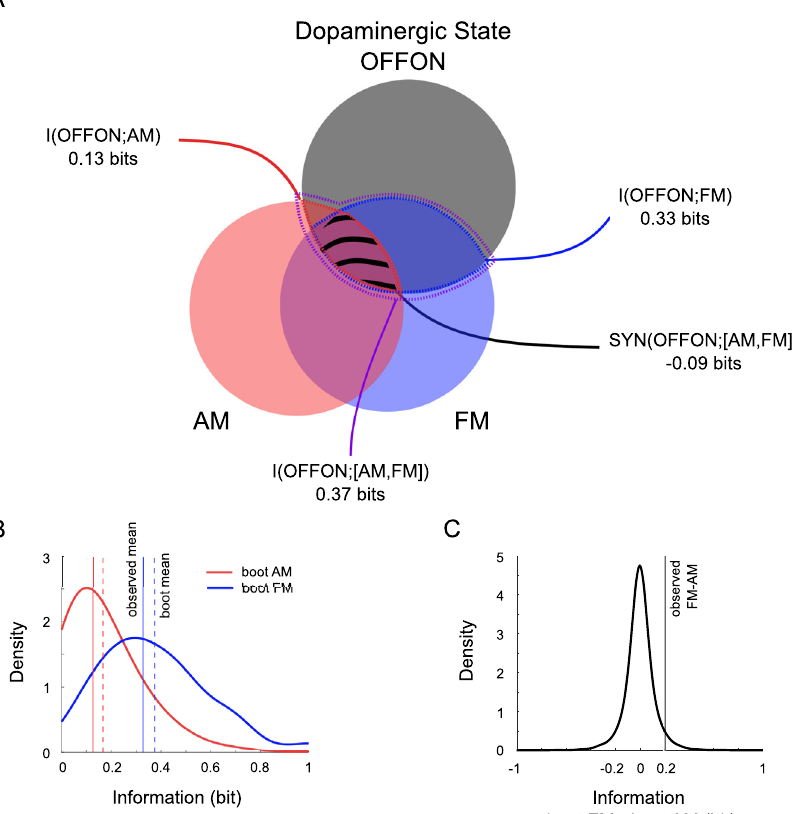
Fig. 4 Information analysis. A Venn diagram representing the information carried by AM and FM about the dopaminergic state (OFFON). The black, red and blue circles represent the entropy of each variable (OFFON, AM and FM respectively). The overlap between circles represents the mutual information between variables. The areas within red, blue and violet dotted lines represent, respectively, the information carried by AM (i.e. I(ONOFF; AM)) the information carried by FM (i.e. I(ONOFF; FM)) and the information jointly carried by AM and FM (i.e. I(ONOFF; [AM,FM])). The area with black dashes represent the redundancy between AM and FM (i.e. negative SYN(ONOFF; [AM,FM])). B Probability density functions of the information carried by AM and by FM estimated using bootstrapping techniques. Vertical lines represent observed (solid) and bootstrapped (dashed) means for AM (red) and FM (blue) distributions. The bootstrapped means correspond well to the observed means, con fi rming that the bootstrapped distributions provide a meaningful representation of the variability of the estimates. The estimated distribution of FM information is greater than the estimated distribution of AM information, providing an intuitive visual representation of the difference between the two estimates (supported by formal hypothesis testing in the next panel). C Probability density function of differences of information between FM and AM estimated using bootstrapping techniques (i.e. under the assumption that the null hypothesis of no difference is true). The vertical line represents the observed FM-AM difference (i.e. ~0.2 bits), showing its low probability under the